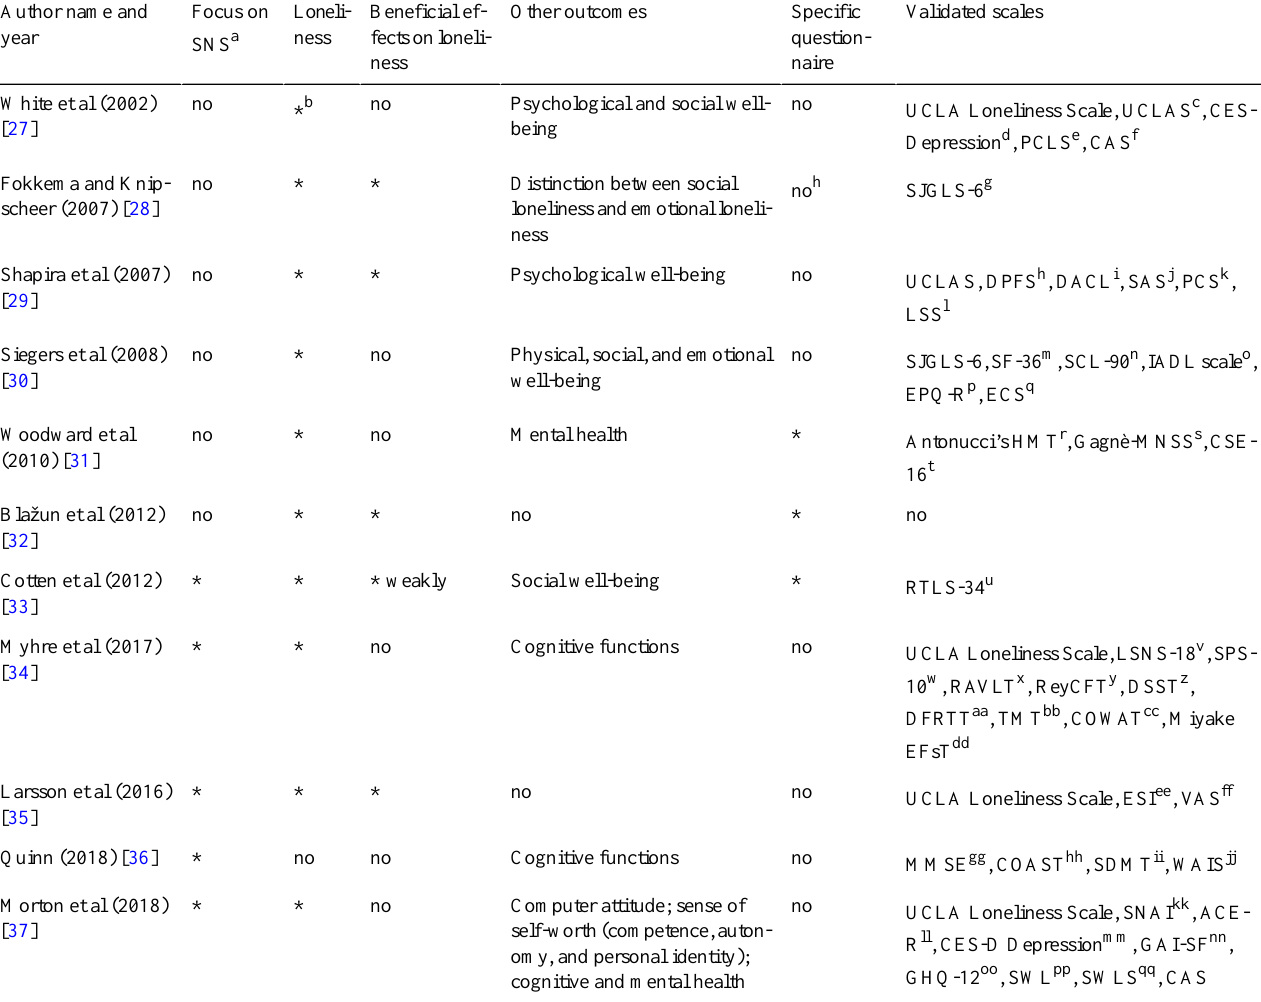
Table 3. Contents of studies: focus on social networking sites, outcomes, and